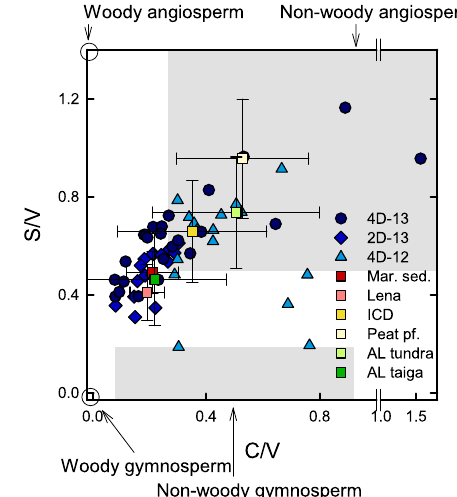
Fig. 3 | Comparison oforganic carbon in subsea permafrost in the Buor-Khaya Bay with other deposits in northeast Siberia. Shown are organic carbon (OC) content,totalorganiccarbonovertotalnitrogen(OC/TN),andorganiccarbon δ 13 C values. All data from cores 4D-13,2D-13, 4D-12,5D-13, and on OC/TN and δ 13 C from core1D-14arefromthisstudy.DatafrompreviousstudiesincludeOCin1D-14 38 and BK-2 28,40 , terrestrial deposits such as Ice Complex deposits (ICD), taberites, ther- moerosion (thermoeros.), and thermokarst/lake deposits (thermok.) of different depositionage 2 ,aswellasBuor-KhayaBaysurfacesediments 14,37 , fl uvialandalluvial ( fl .,alluv.)depositsthatareaffectedbytranslocation.Boxplotsshowmedianswith 25thand75thpercentilesasboxlimits,minimum/maximumvaluesaswhiskers,and numbers of observations in italics.